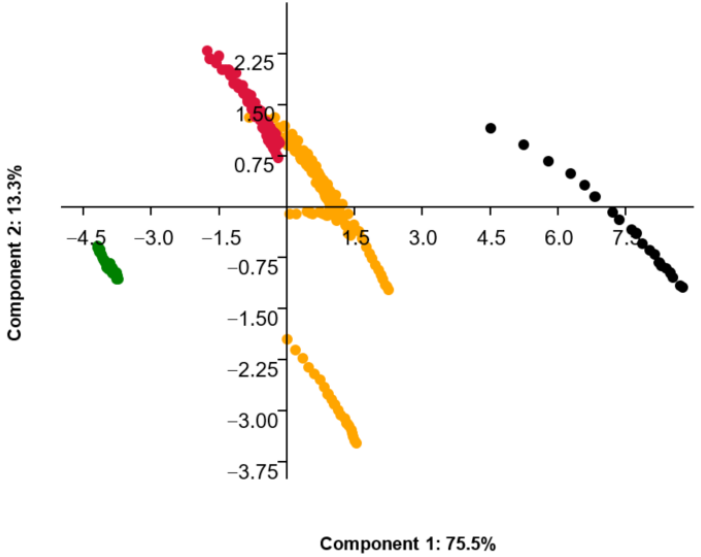
Figure 7. PCA based on electronic-nose data, clustered by wood assortments. Black dots, control sample; orange dots, peeled wood; red dots, sliced wood; green dots, wood tablets.